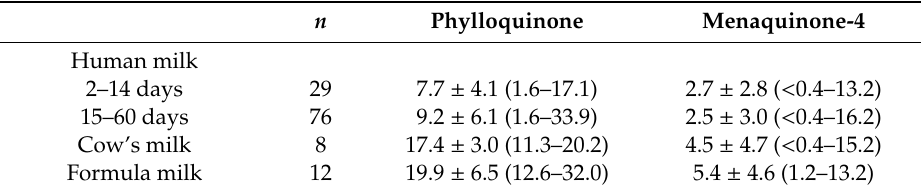
Mean ± SD. Numbers in parentheses indicate a